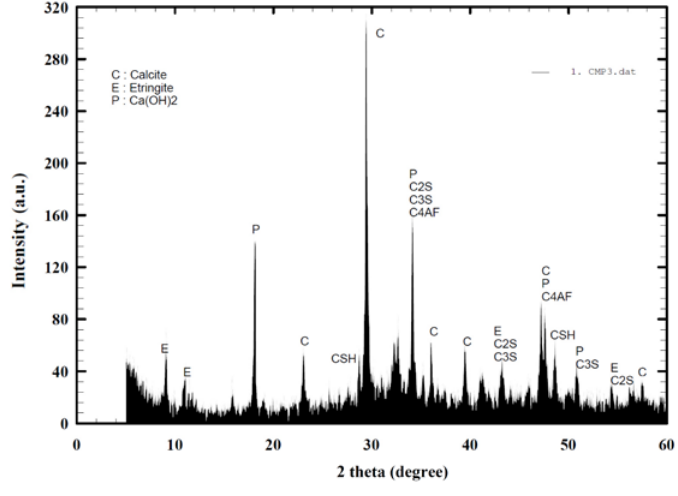
Figure 9. XRD results for marble powder–cement paste.